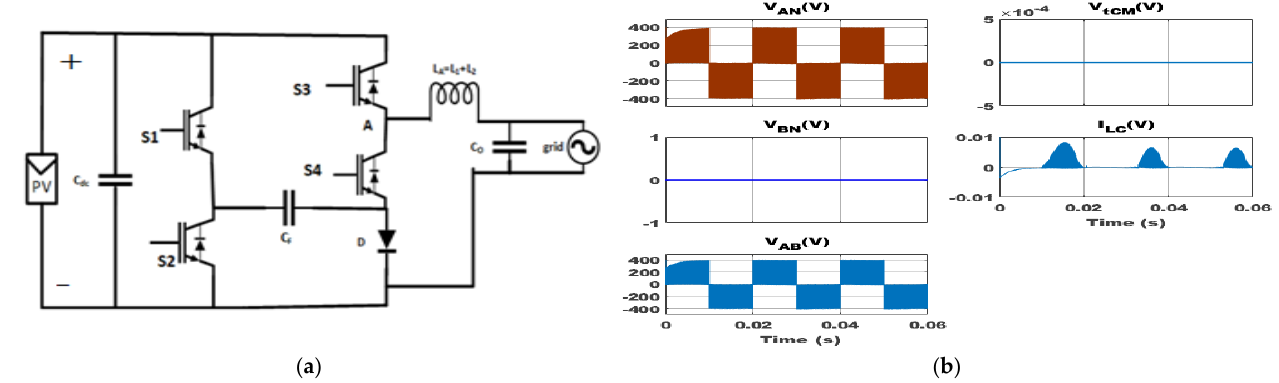
Figure 21. Flying Capacitor Type-II topology: ( a ) circuit structure; ( b ) simulation results.